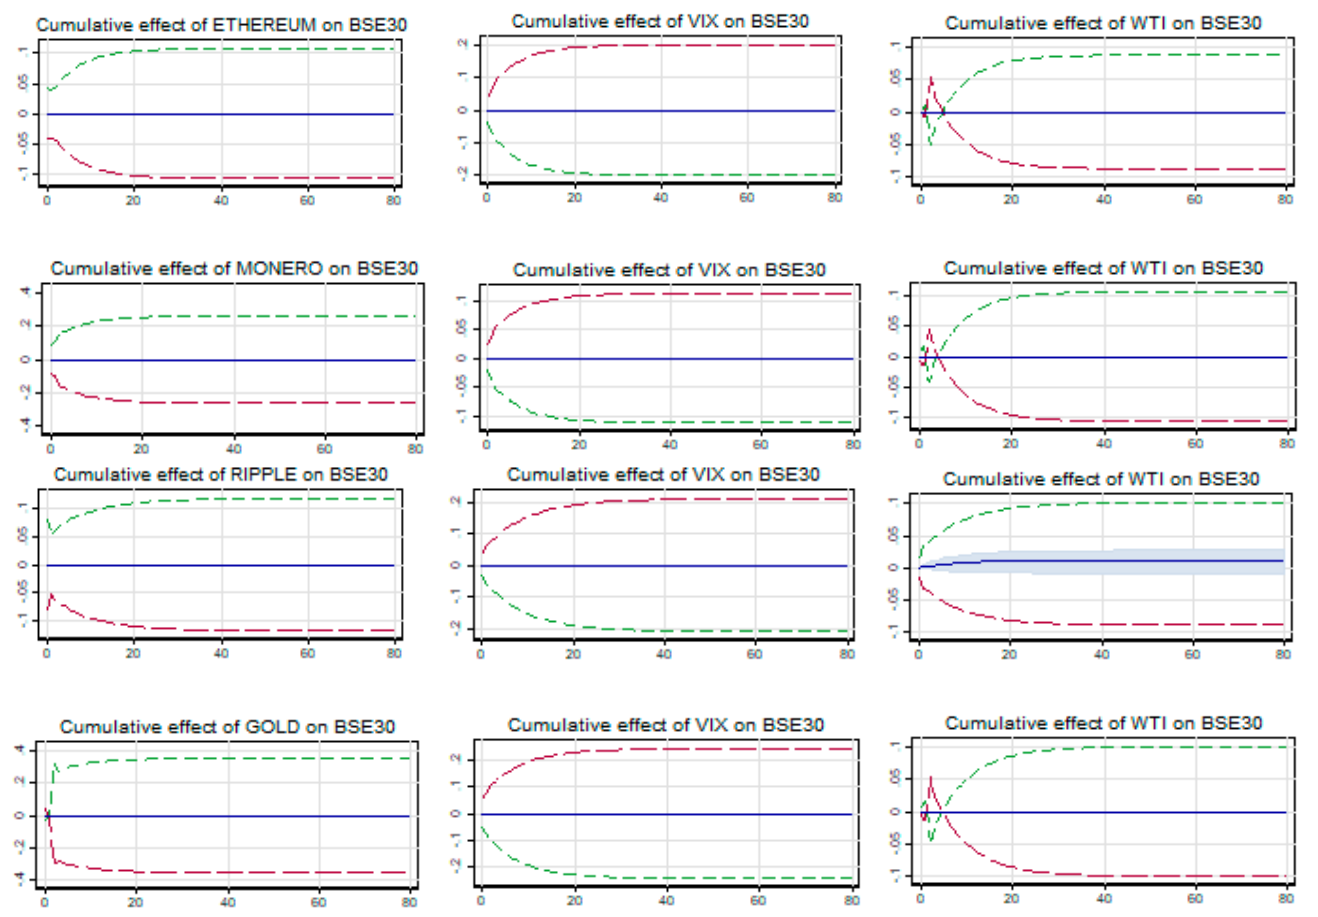
Figure 6. Cumulative effects of cryptos and gold on BSE30.